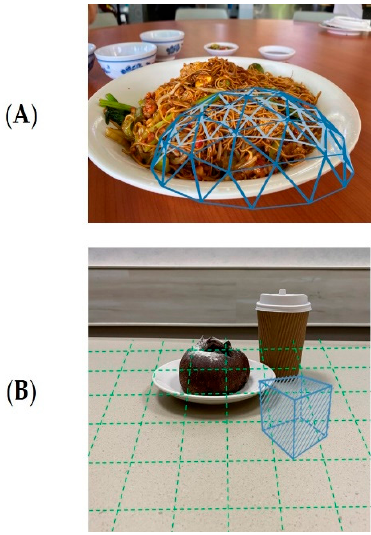
Figure 3. Food volume estimation using geometric modelling. ( A ) Movable spherical cap as adapted from Jia et al. 2014; ( B ) Projected variable cube using AR technology as adapted from Yang et al. 2019.